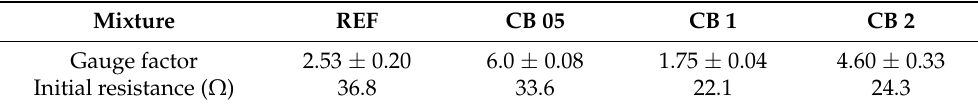
Table 3. Calculated gauge factors.